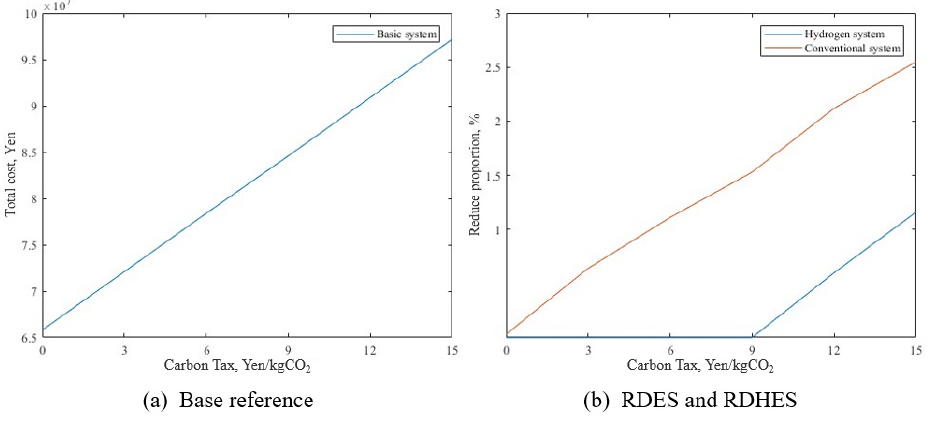
Figure 5. Total cost base reference value change ( a ) and the proportion of total cost reduction under different carbon taxes ( b ).